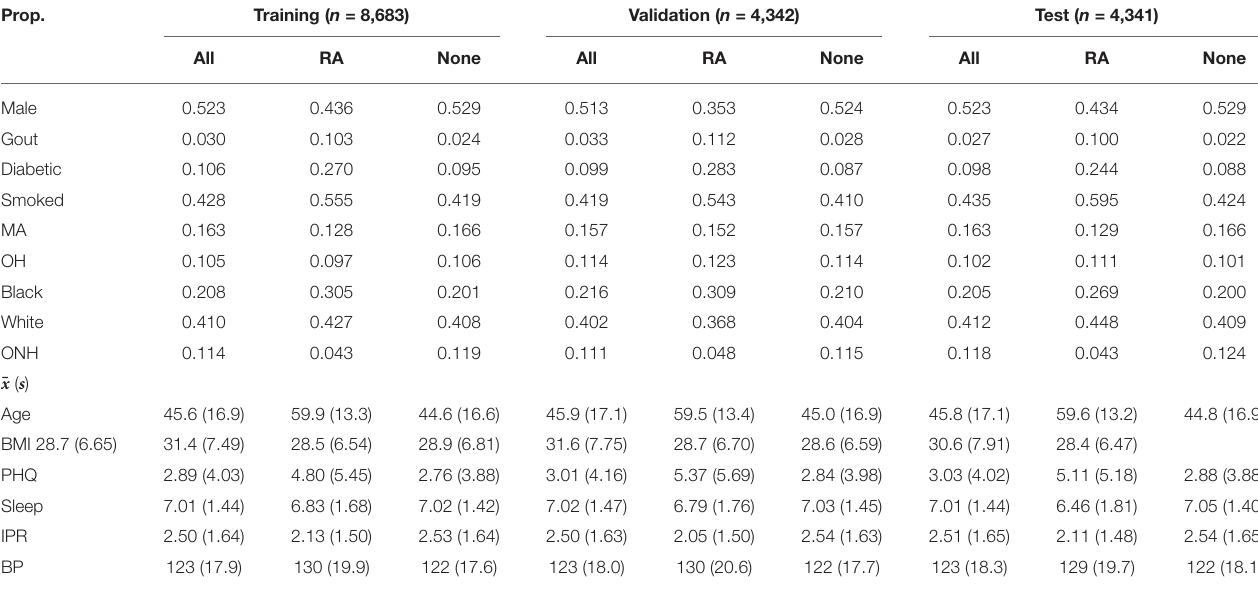
TABLE 2 | Breakdown of participants into training, validation, and test datasets with comparison of summary characteristics between RA and no arthritis (None) groups in each dataset.